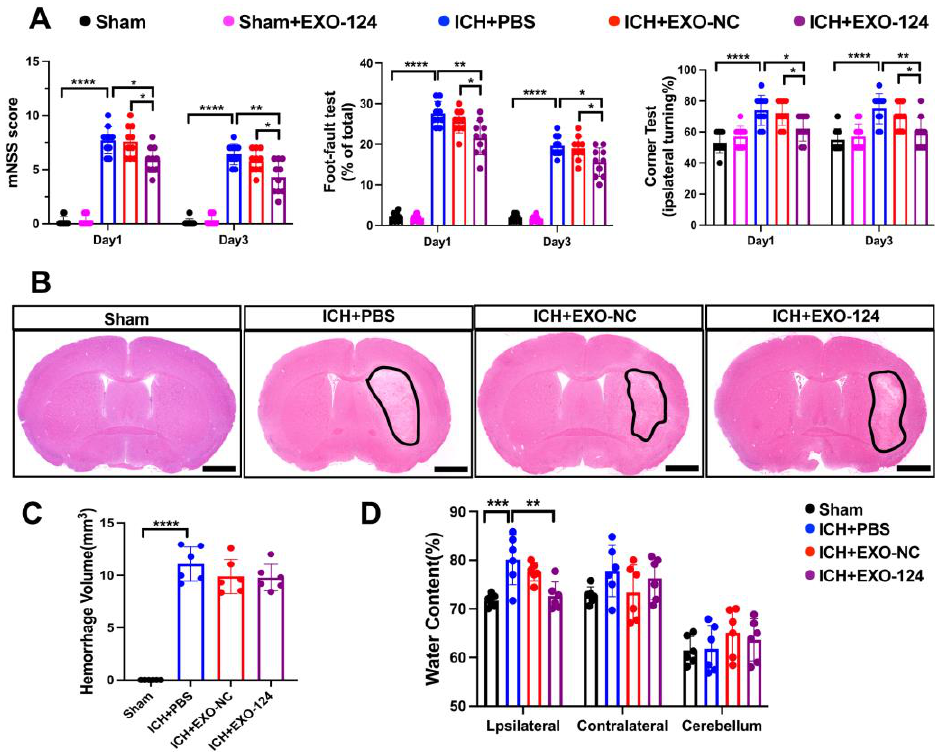
Figure 3. miRNA-124-enriched microglia-derived exosomes attenuate neurological deficits, brain edema and hematoma volume after ICH. ( A ) Summary of mNSS score and performance in the foot-fault test and corner turning test on days 1 and 3 after ICH induction. n = 10/group, mean ± SD, * p < 0.05, ** p < 0.01, **** p < 0.0001. ( B ) H&E staining was used to assess the hematoma volume in the regions outlined in black. Scale bar: 1 mm. ( C , D ) Quantification of the hematoma volume and brain water content at day 3 after ICH. n = 6/group, mean ± SD, ** p < 0.01, *** p < 0.001, **** p <